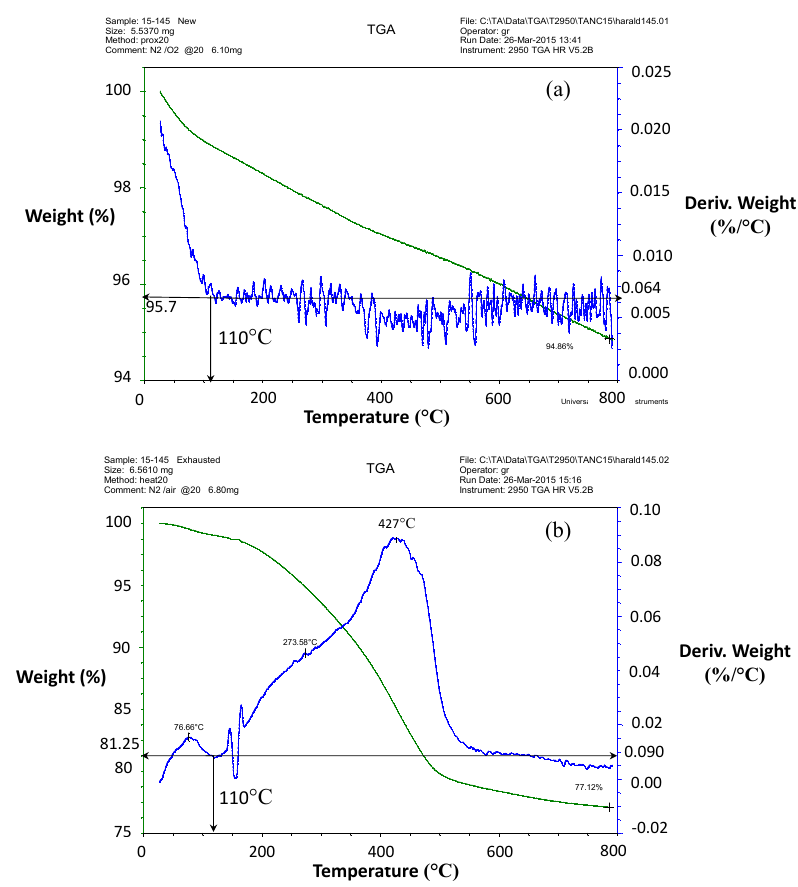
Figure 7. TG and DTG curves for GAC ‐ 1 ( a ) and GAC ‐ 5 ( b ) in N 2 atmosphere.